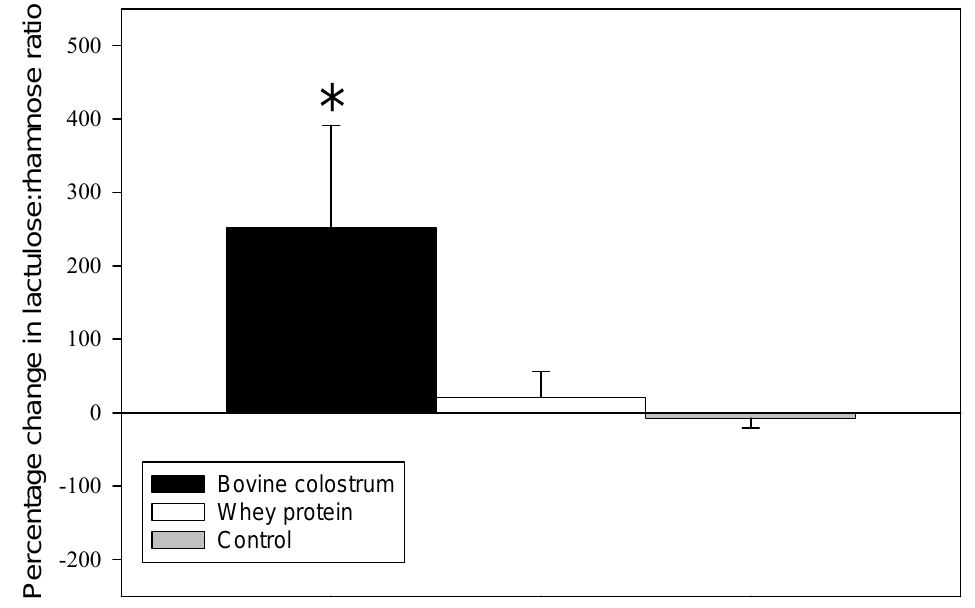
Figure 1 Percentage change from baseline in lactulose/rhamnose ratio following eight weeks of endurance exercise training and supplementation with 60 g  day -1 of concentrated bovine colostrum protein powder, concentrated whey protein powder, or no supplement (Control). * Significantly different from whey protein (P < 0.05) and control (P <